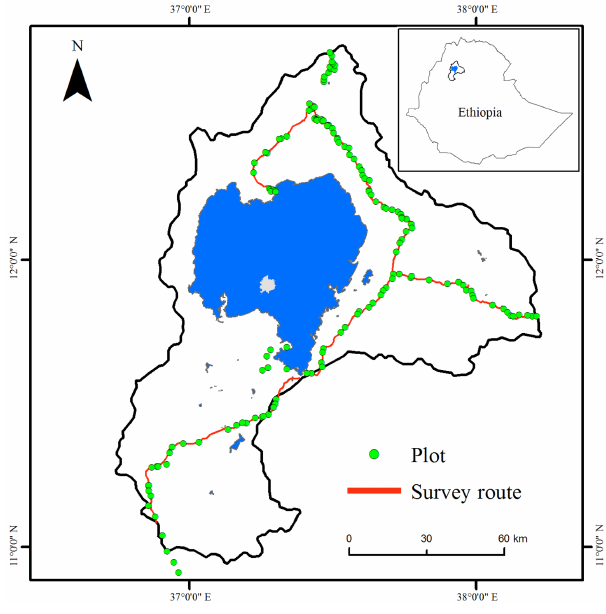
Figure 1. Location of the Lake Tana basin, survey route, and